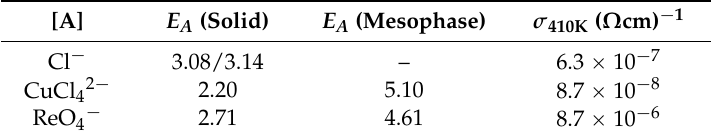
Table 4. Activation energies E A for the Cl − , CuCl 42 − and ReO 4 − salts in the solid phase and the mesophase. Note that the Cl − does not exhibit a mesophase. Conductivity values are given at 410 K in